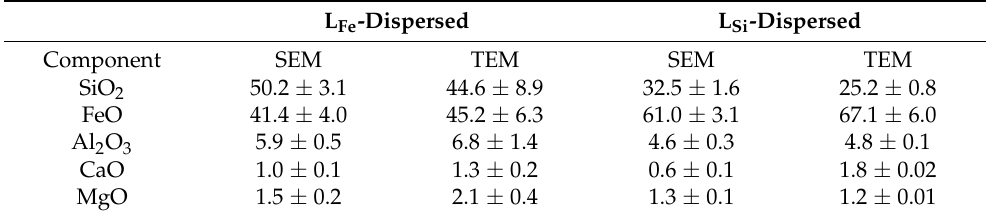
Table 1. Bulk composition of amoeboids as measured by SEM (average) and TEM in oxide weight percent. L Fe -Dispersed L Si -Dispersed